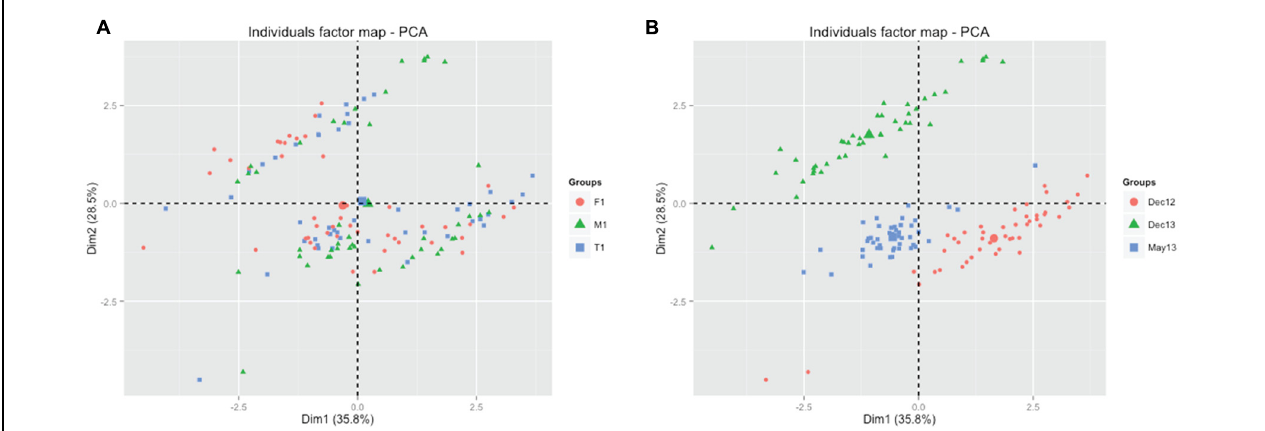
FIGURE 3 | Principal component analysis (PCA) biplot showing the clustering of microbial functional gene abundances per plantation type (A) and per sampling date (B). T: teak; F: flueggea; M: mixed; Dec12: December 2012; May13: May 2013; Dec13: December